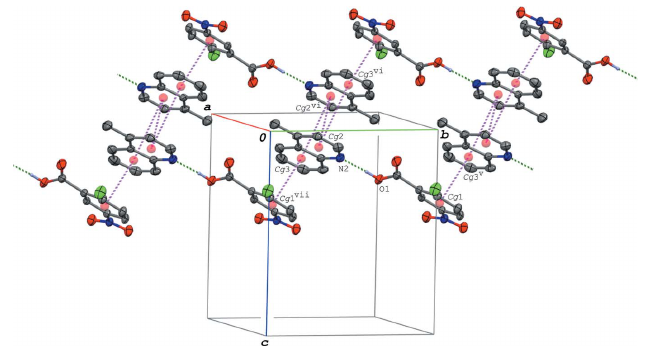
Figure 5 A packing diagram of (II), showing the ribbon structure running along the b- axis direction formed via the O—H (cid:2)(cid:2)(cid:2) N hydrogen bonds (green dashed lines) and (cid:2) – (cid:2) interactions (magenta dashed lines). H atoms not involved in the hydrogen bonds are omitted for clarity. Cg 1, Cg 2 and Cg 3 are the centroids of the C1–C6, N2/C8–C11/C16 and C11–C16 rings, respectively. [Symmetry codes: (v) x , y + 1, z ; (vi) (cid:3) x + 1, (cid:3) y + 1, (cid:3) z ; (vii) x , y (cid:3) 1, z